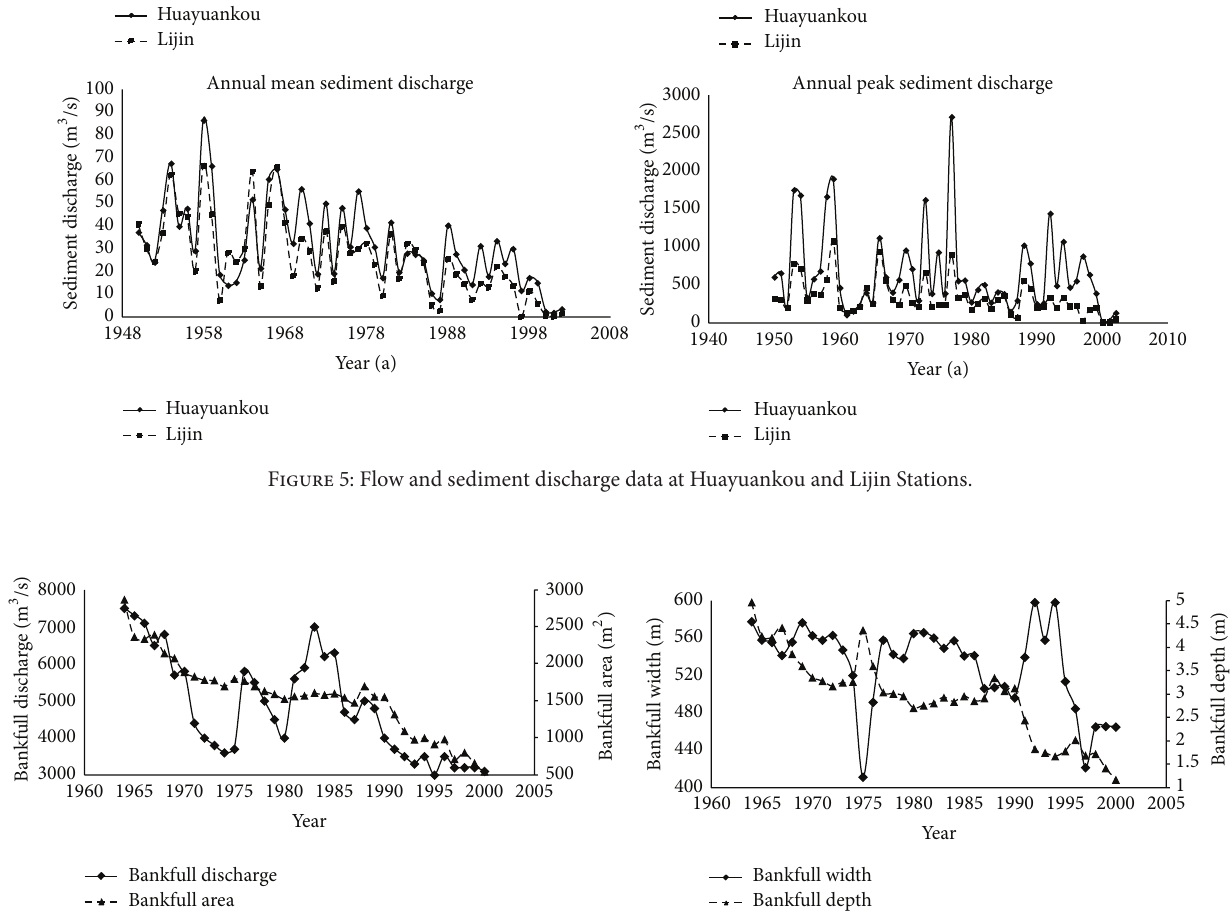
Figure 6: Observed bankfull characteristics at Lijin Station: (a) bankfull discharge and area; (b) bankfull width and depth.